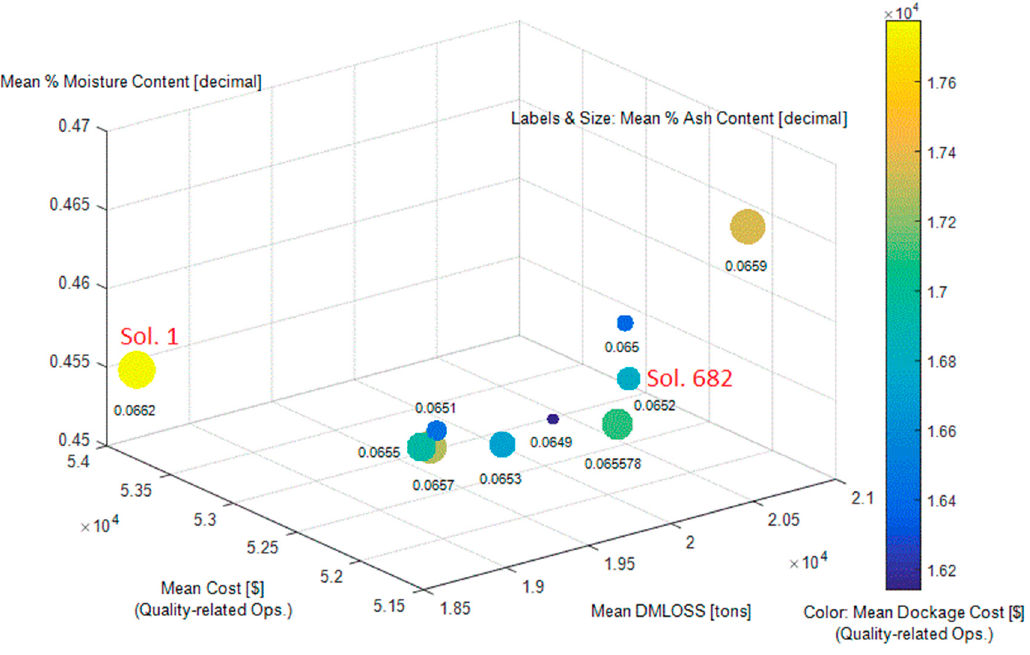
Figure 12. Solutions 1 and Solutions 682 (schedule 1).